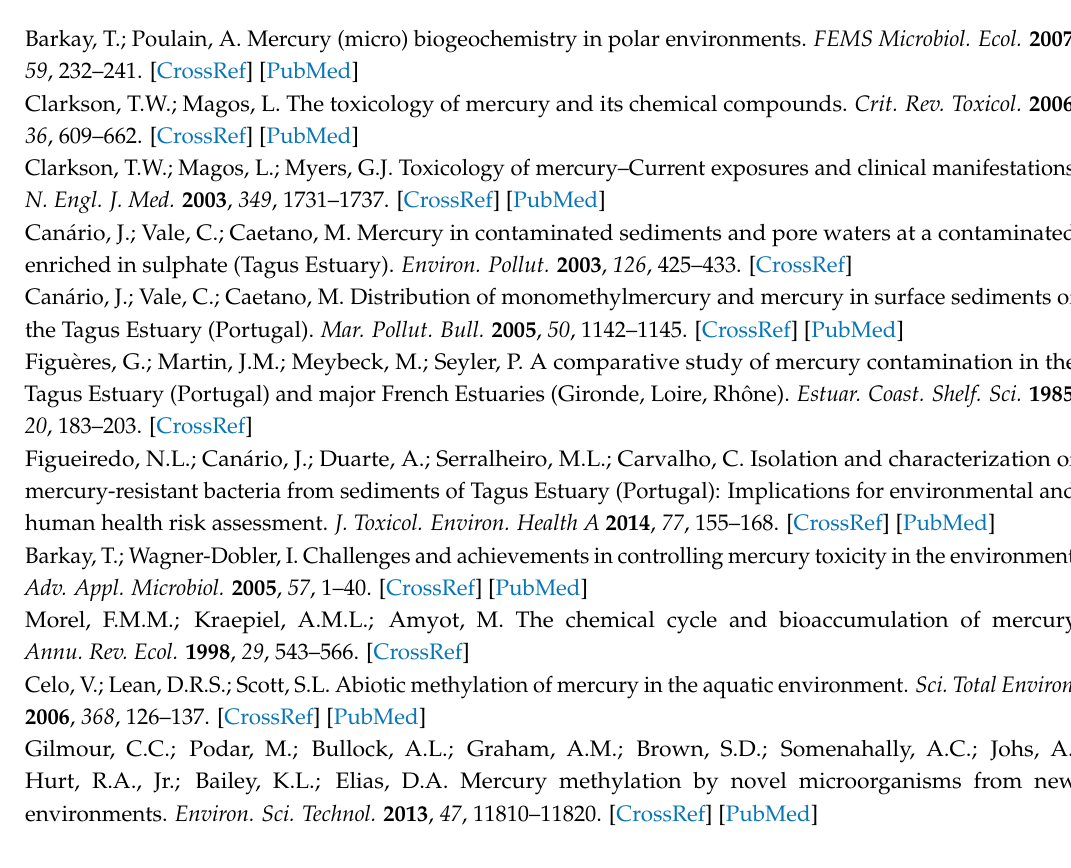
Table S1: Isolates identified among the three studied communities. The identifications were based on 16S rRNA amplification and sequencing. Parts of the data were previously published